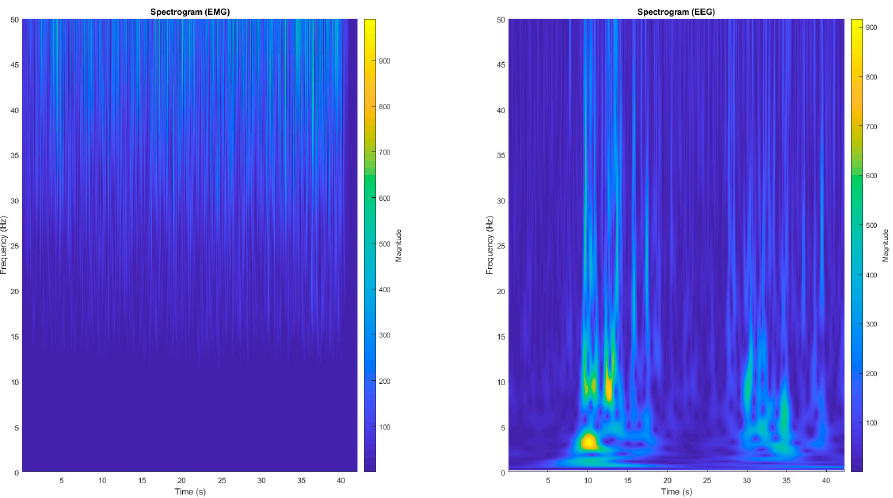
Figure 4. Spectrogram of EEG gamma wave at Cz position and vastus lateralis electromyography